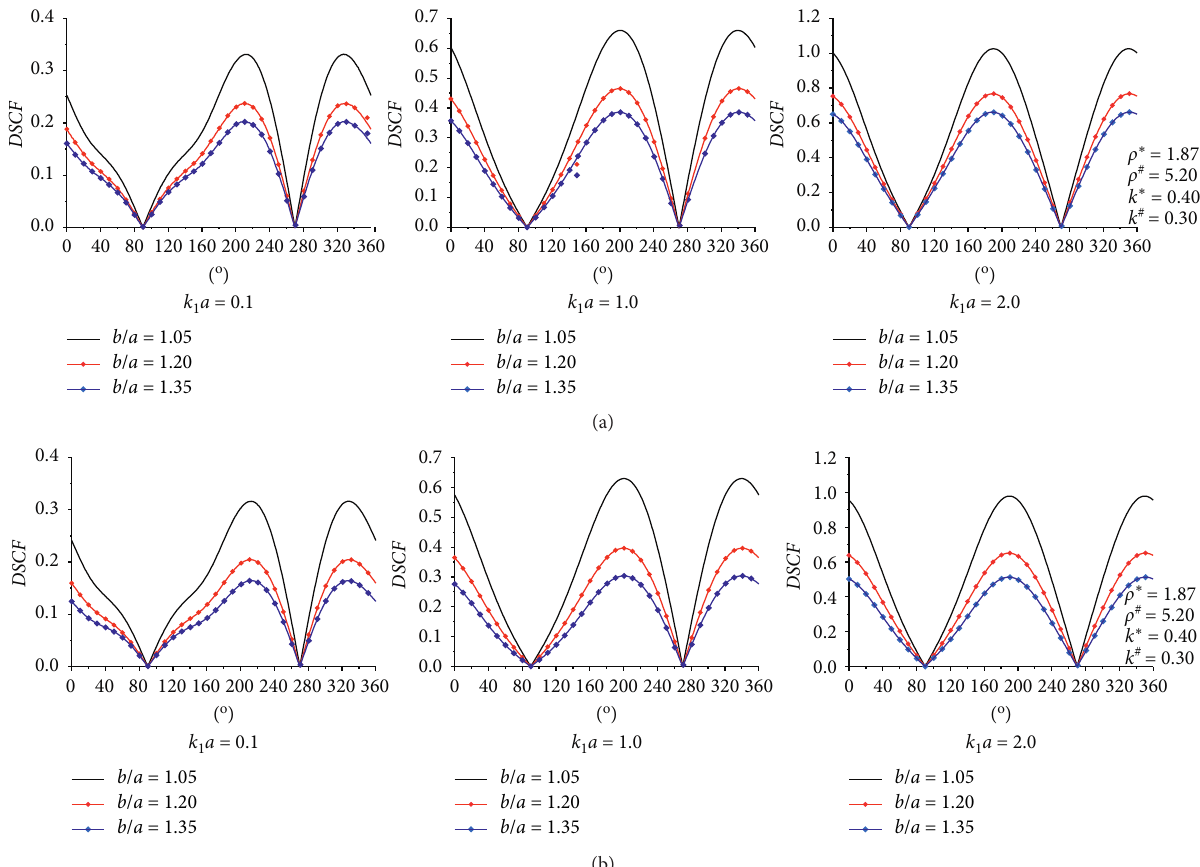
Figure 11: DSCF of linings composed of grade Q345 steel for geological Condition B. (a) Condition B-Q345: inner surface. (b) Condition B-Q345: outer